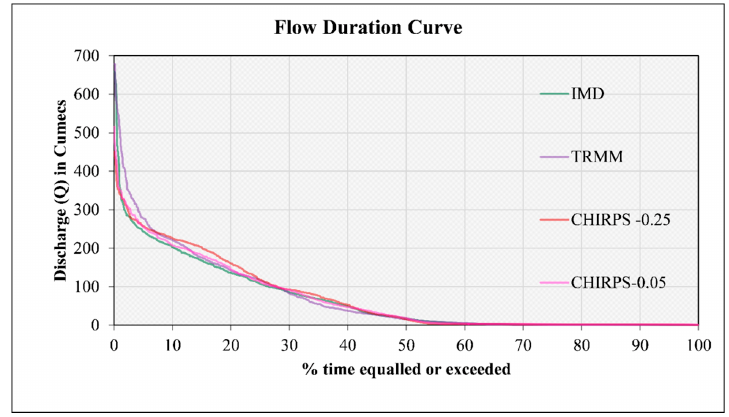
Figure 6. Daily flow duration curve for the Gurpura river at the Addoor station.